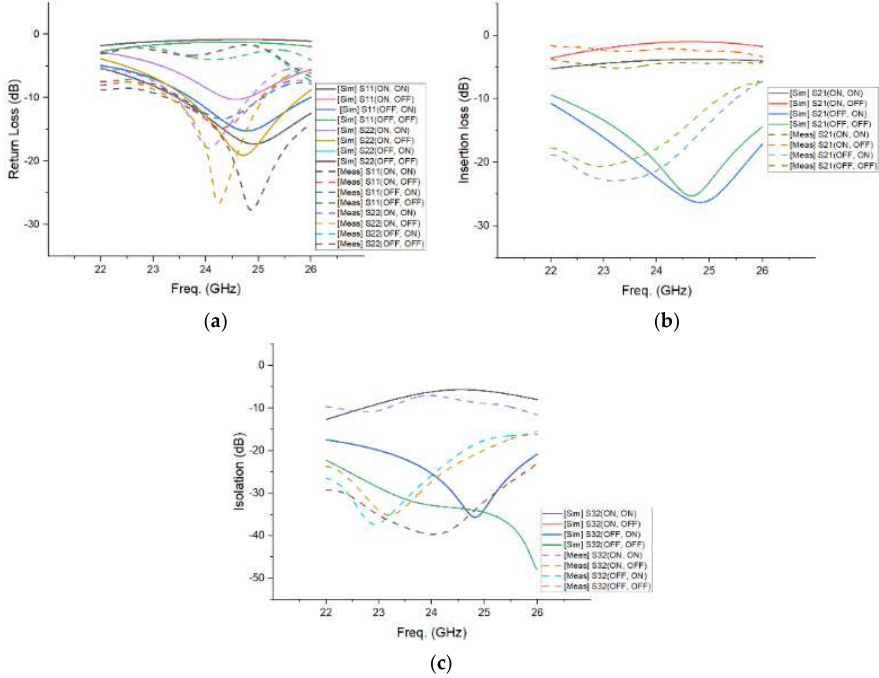
Figure 8. S − parameters of the designed RF switch: ( a ) return loss, ( b ) insertion loss, and ( c )